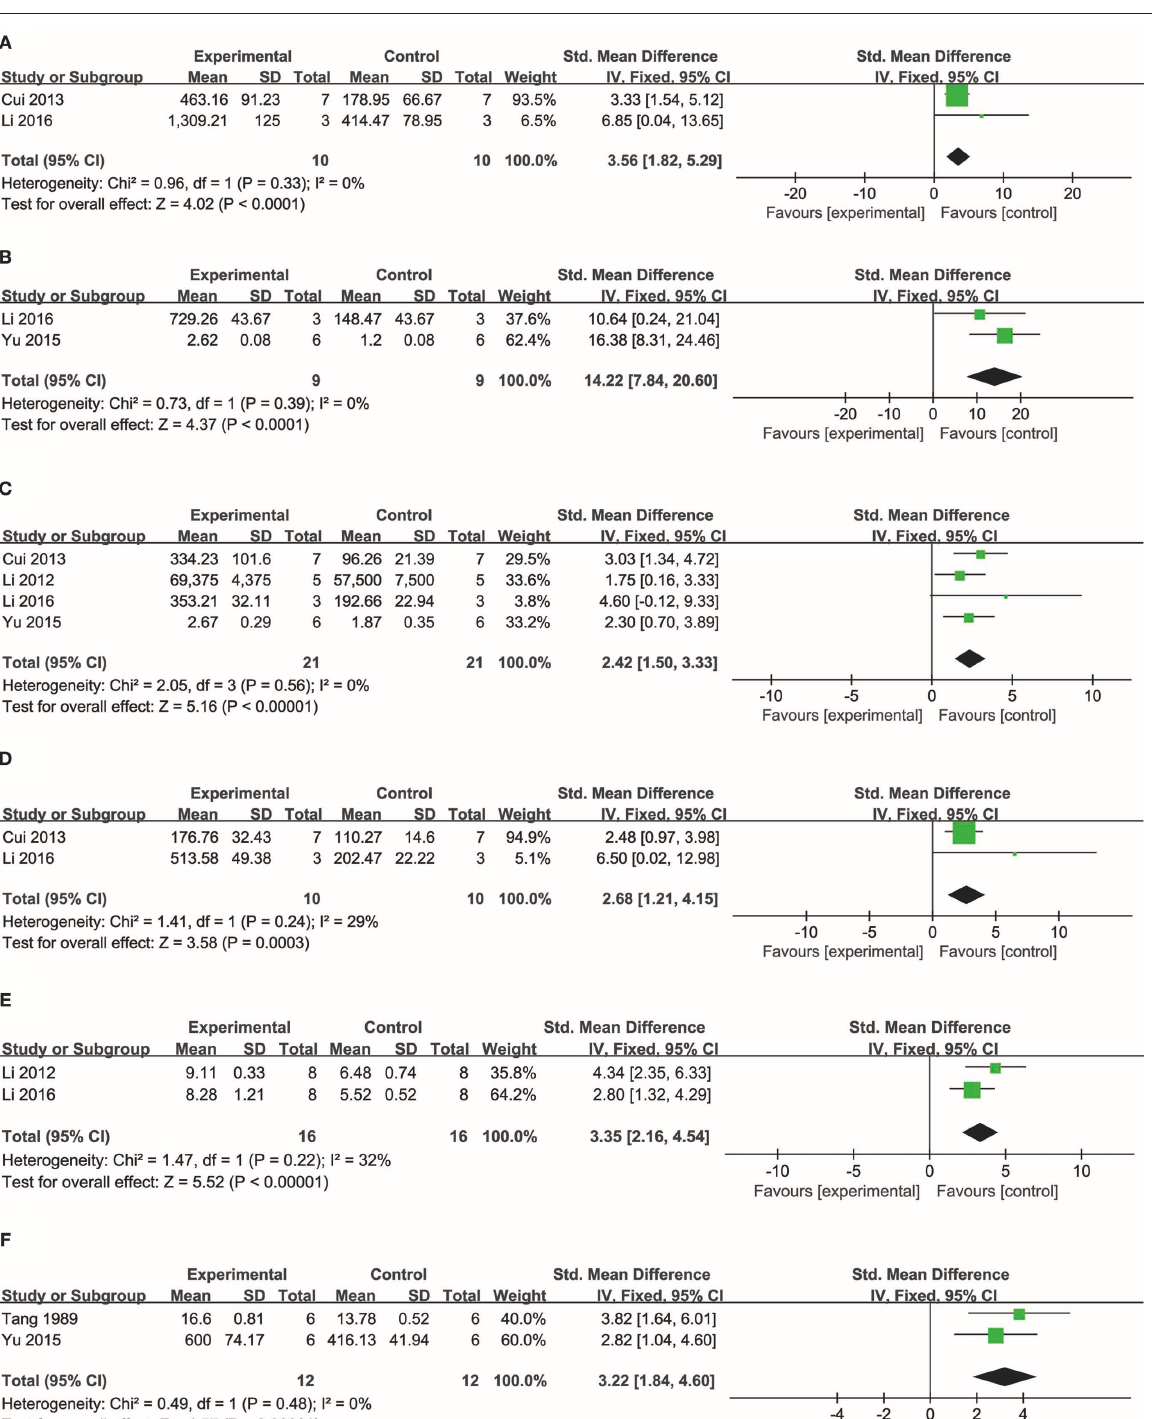
Frontiers in Pharmacology | www.frontiersin.org